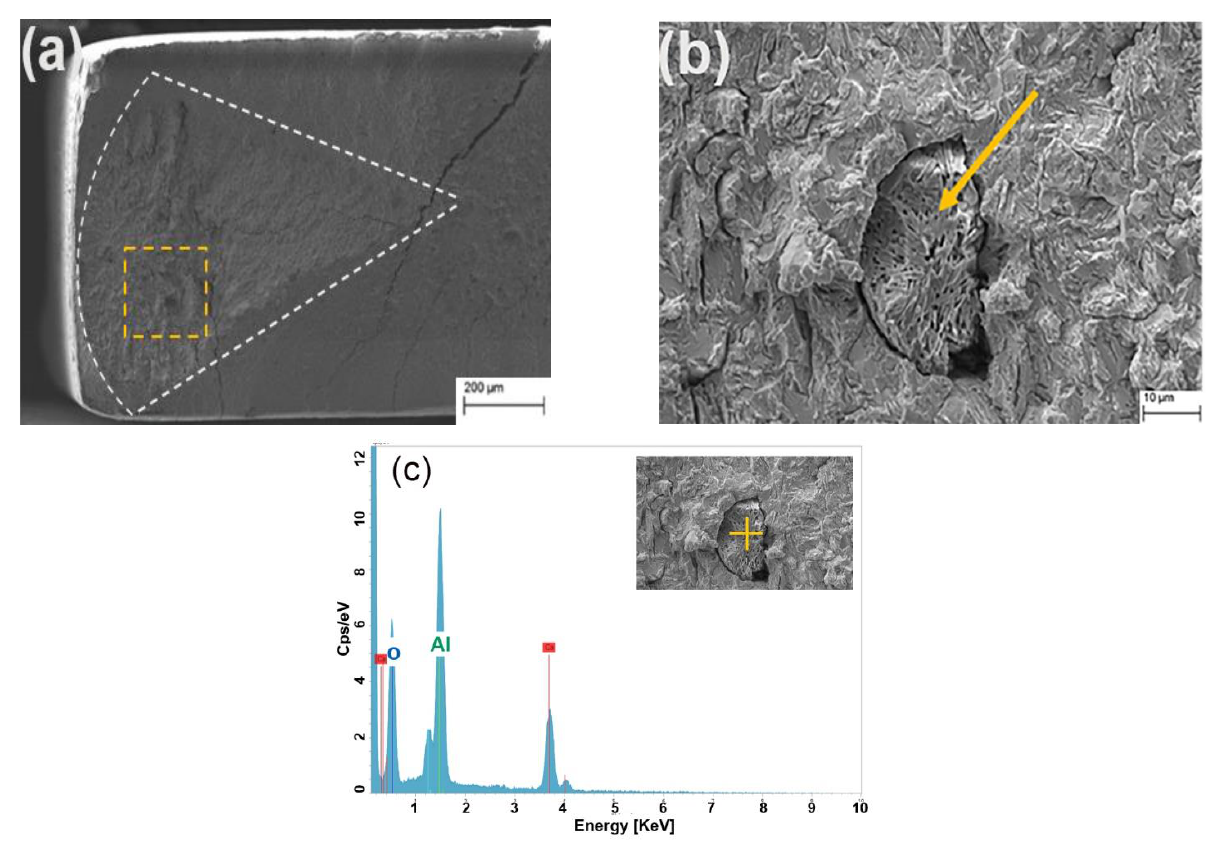
Figure 11. ( a ) Fractography of the specimen charged to 1.1 wt.ppm; ( b ) higher magnification of the yellow square in ( a ) showing the crack initiation from an inclusion, ( c ) revealed by energy dispersive spectroscopy (EDS) to be an Al 2 O 3 particle.